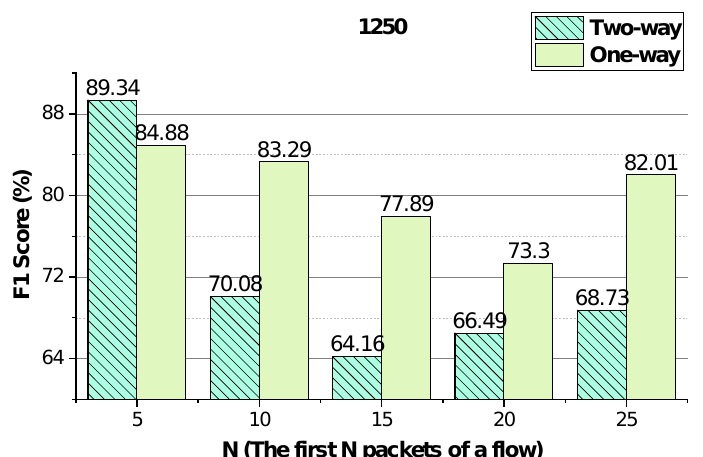
Figure 7. When the integer conversion value of the packet inter-arrival time is 1250, the VPN traffic detection performance of the method using the two-way and one-way packet inter-arrival time sequences of the flow, respectively.